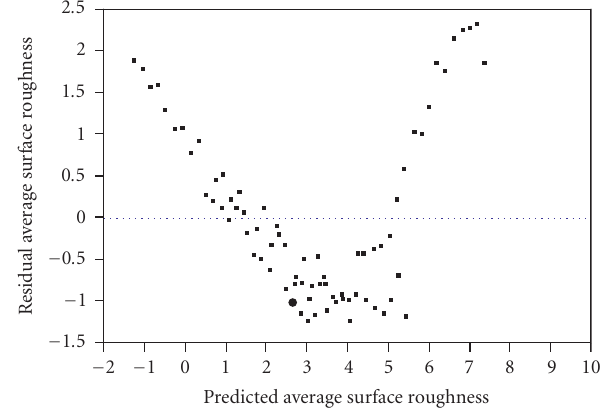
Figure 6: The residual surface roughness versus predicted surface roughness of main e ff ects